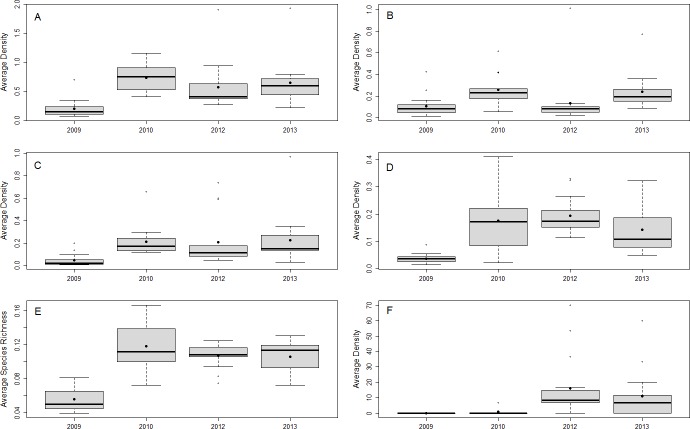
Small fish community responses and lionfish abundance over time.Boxplots of site-averaged total abundance (individuals/m2) (A), family-specific abundance (individuals/m2) (Pomacentridae, Labridae, and Scaridae B–D, respectively), and species richness (species/m2) (E) of prey small fish, as well as lionfish abundance (individuals/ha) (F) for each survey year. Boxes indicate the first and third quartiles with the median shown by the thicker transecting line. Mean values are indicated by the filled black dots.